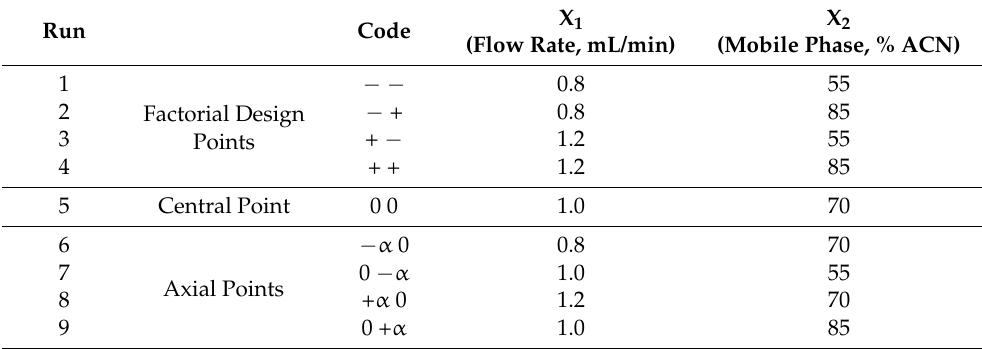
Table 4. Face-centered central composite design (FcCCD) matrix for the evaluation of flow rate (X 1 ) and mobile phase composition (X 2 ). For each condition, two calibration standard solutions were considered (1 and 100 µ g/mL) in order to inspect the impact of impurities on the critical analytical attributes